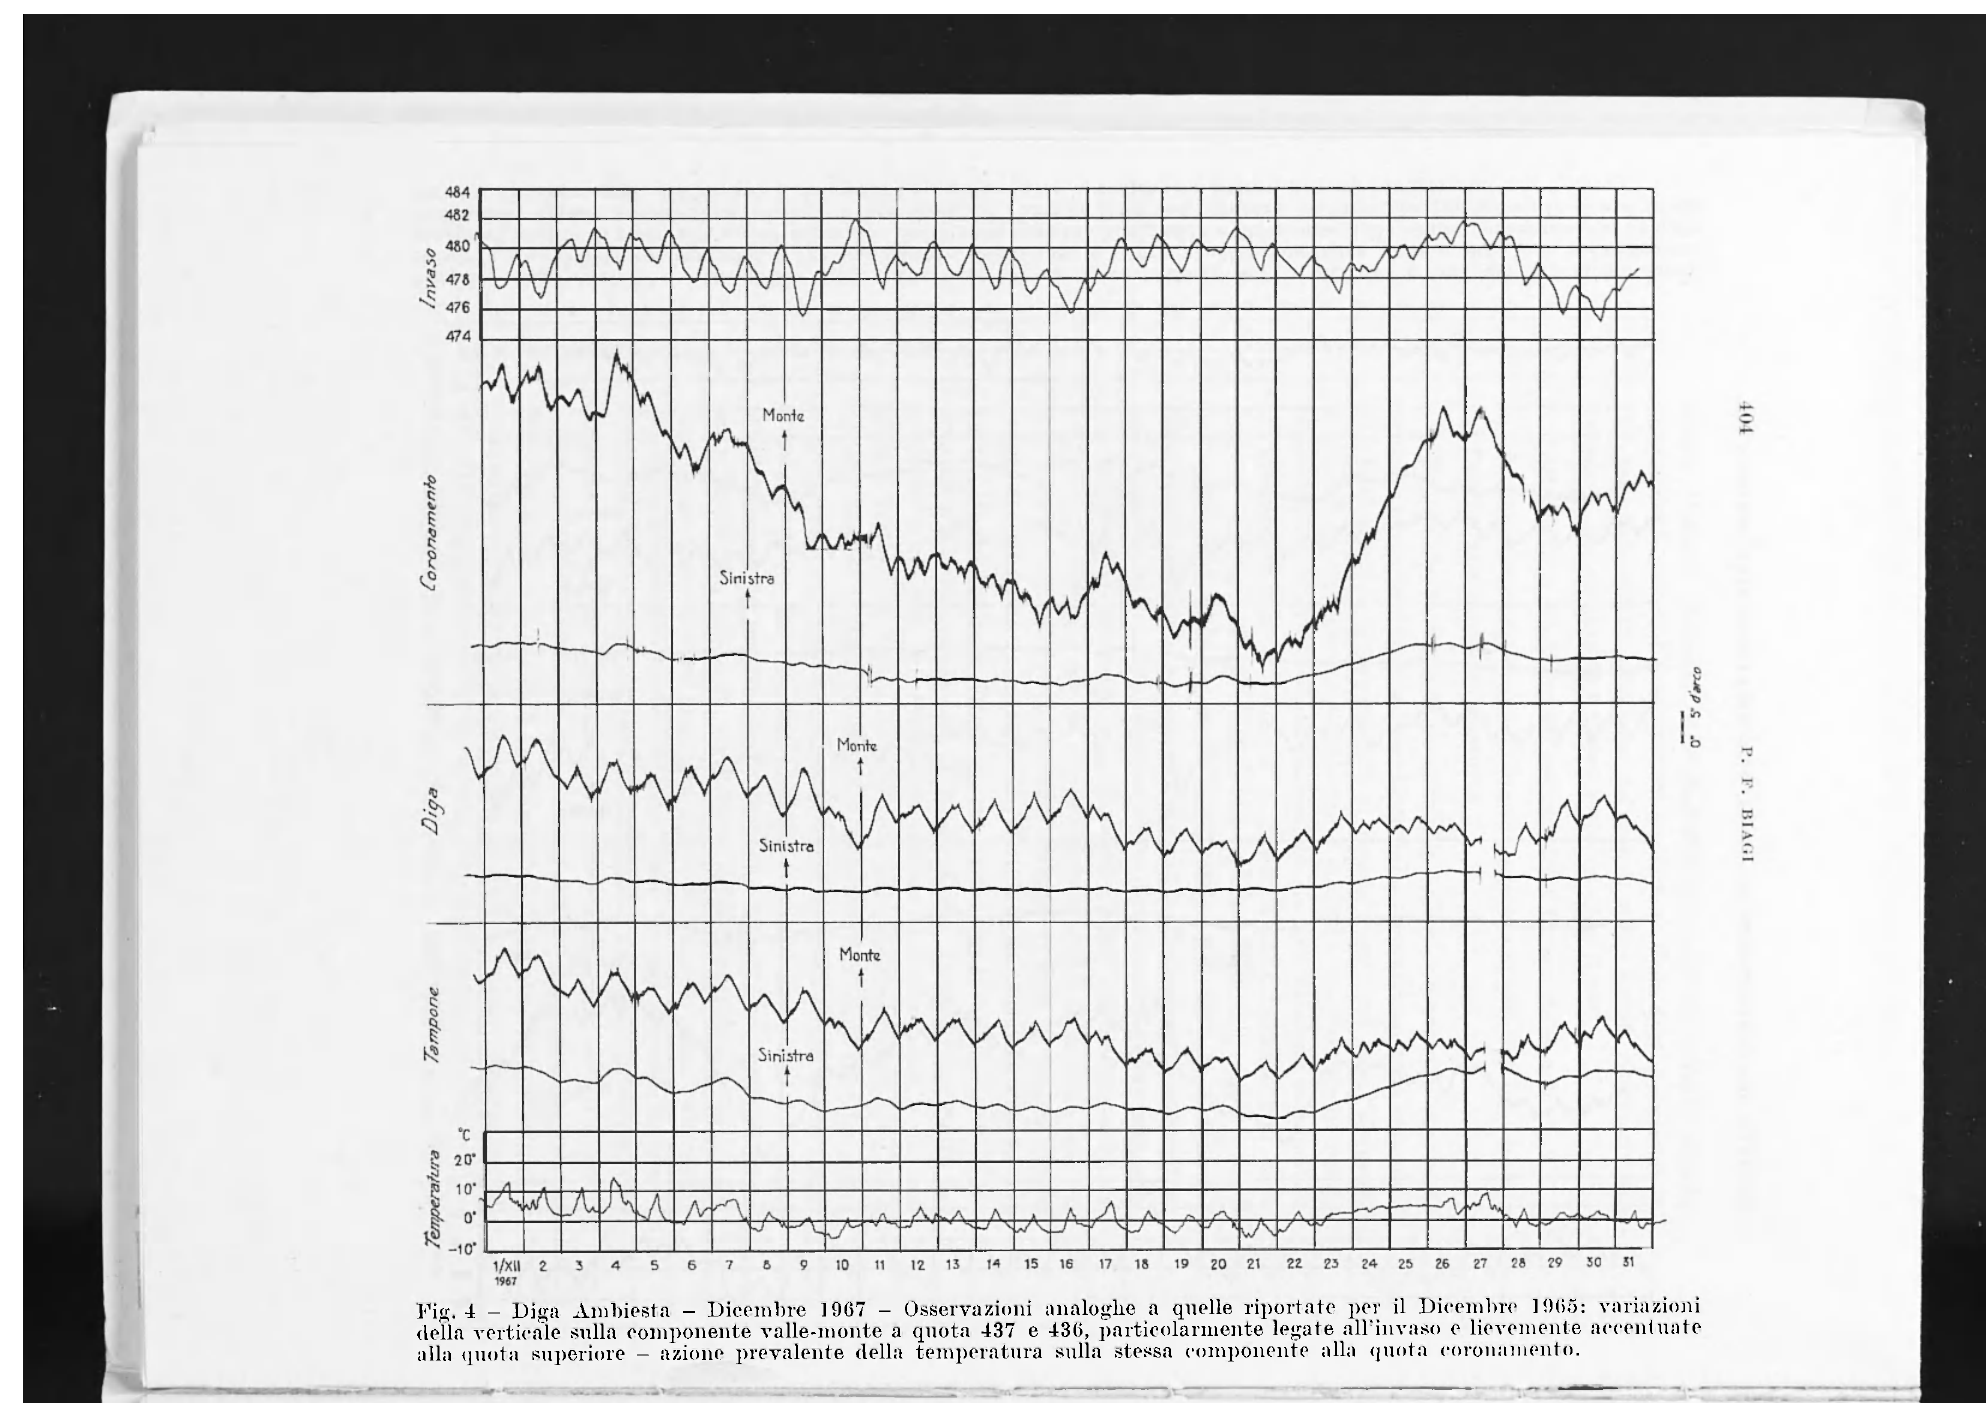
Fig. 4 - Diga Ambiesta - Dicembre 1967 - Osservazioni analoghe a quelle riportate per il Dicembre 1905: variazioni della verticale sulla componente valle-monte a quota 437 e 430, particolarmente legate all'invaso e lievemente accentuate alla quota superiore - azione prevalente della temperatura sulla stessa componente alla quota